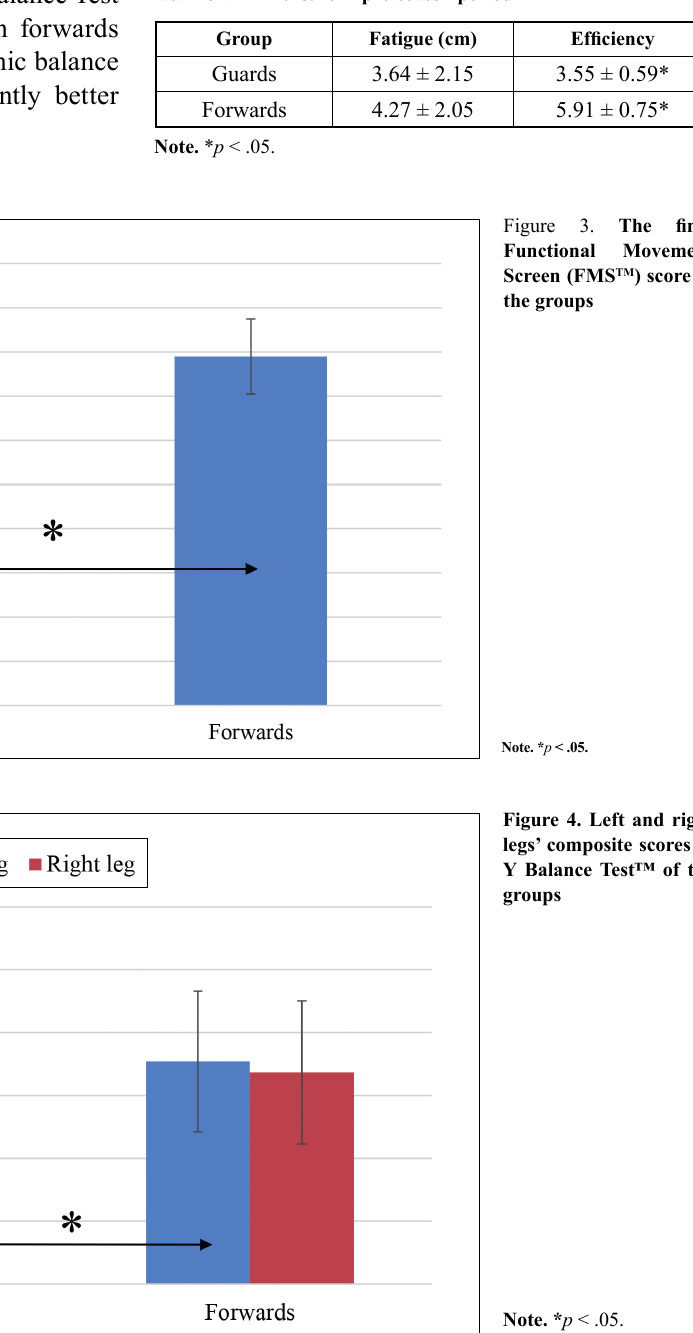
Table 2. Efficiency of groups and physical fatigue intensity in the last month in 2013/2014 pre-season period